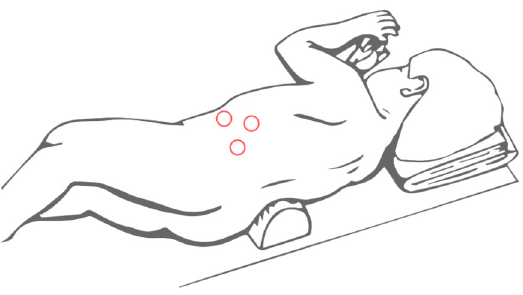
Figure 4. Trocars site for retroperitoneal laparoscopic adrenalectomy.